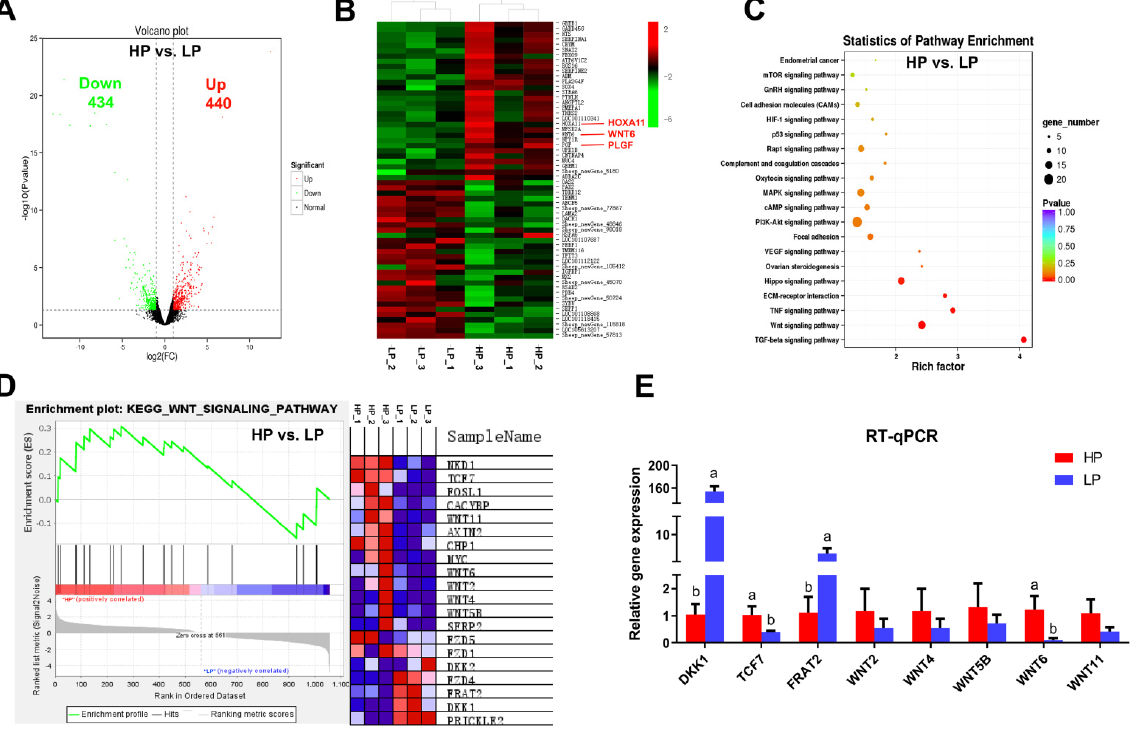
Figure 2. Analysis of DE mRNAs in the endometrium of Hu sheep with different fecundity. ( A ) Volcano plots of DE mRNAs. ( B ) The clustering analysis of mRNAs that were differentially expressed analysis of DE mRNAs (Top 30). ( C ) KEGG functional annotation of DE mRNAs. ( D ) Overview of GSEA used to identify the differential gene profiles in WNT signaling pathway. ( E ) Validation of RNA-seq results by RT-qPCR. The values represent means ± SDs. Means with different letters indicate significant differences ( p < 0.05).